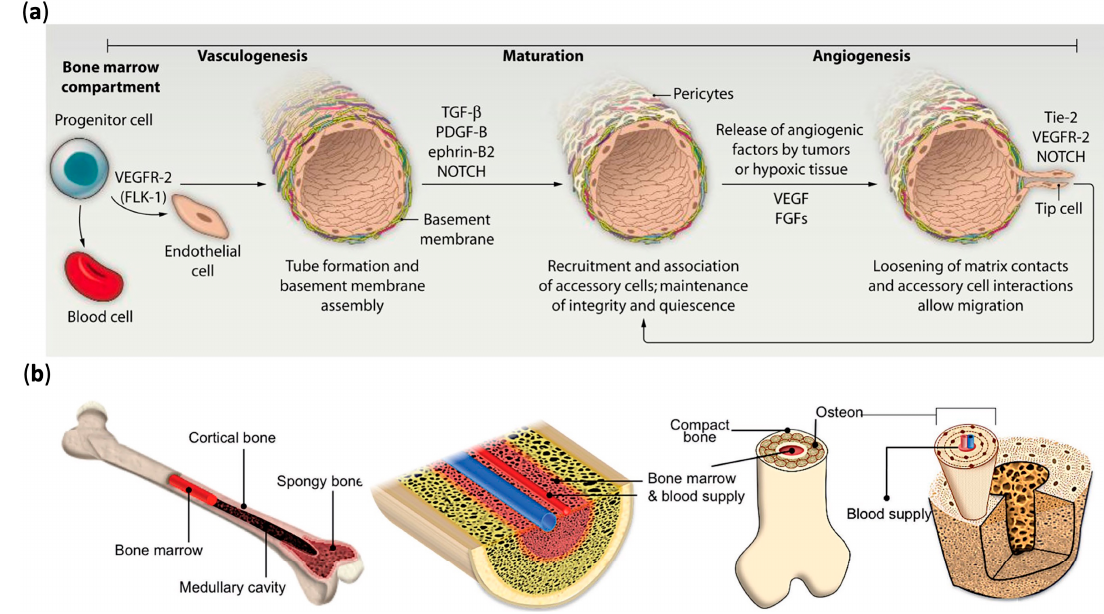
Figure 1. ( a ) The process of vasculogenesis and angiogenesis; ( b ) the schematic illustration of complex bone tissue with vascular structure. Reprinted with permission from References [29,30].